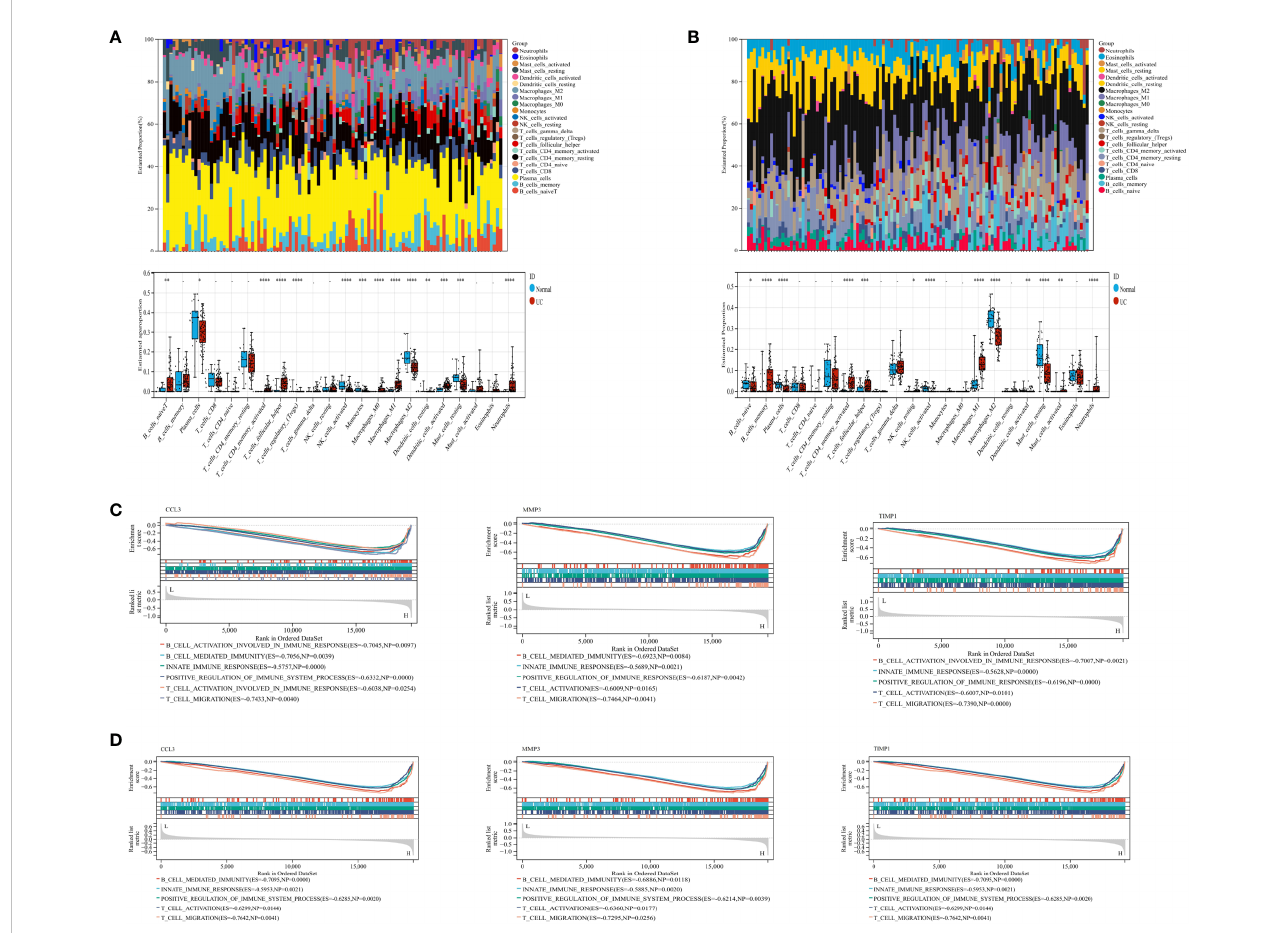
FIGURE 2 CIBERSORT was used to determine immune cell in fi ltration status in samples from the GSE87466 and GSE107499 datasets. GSEA was performed on CCL3, MMP3, and TIMP1 to identify biological processes. (A) Stacked bar plots and box plots show the relative levels of 22 immune cells in the GSE87466 dataset. (B) Stacked bar plots and boxplots show the relative levels of 22 immune cells in the GSE107499 dataset. (C, D) GSEA shows the biological processes related to CCL3, MMP3, and TIMP1 in GSE87466 and GSE107499. "*" corresponds to a signi fi cant level of 5%, that is, p<0.05. p<0.05 indicates that the difference is 95% certain and has statistical signi fi cance. "**" corresponds to a signi fi cant level of 1%, that is, p<0.01, which indicates that the difference is 99% certain, and the difference is signi fi cant, with statistical signi fi cance. "***" corresponds to a signi fi cant level of 0.1%, that is, p<0.001. p<0.001 indicates that the difference is 99.9%, which is very signi fi cant and statistically signi fi